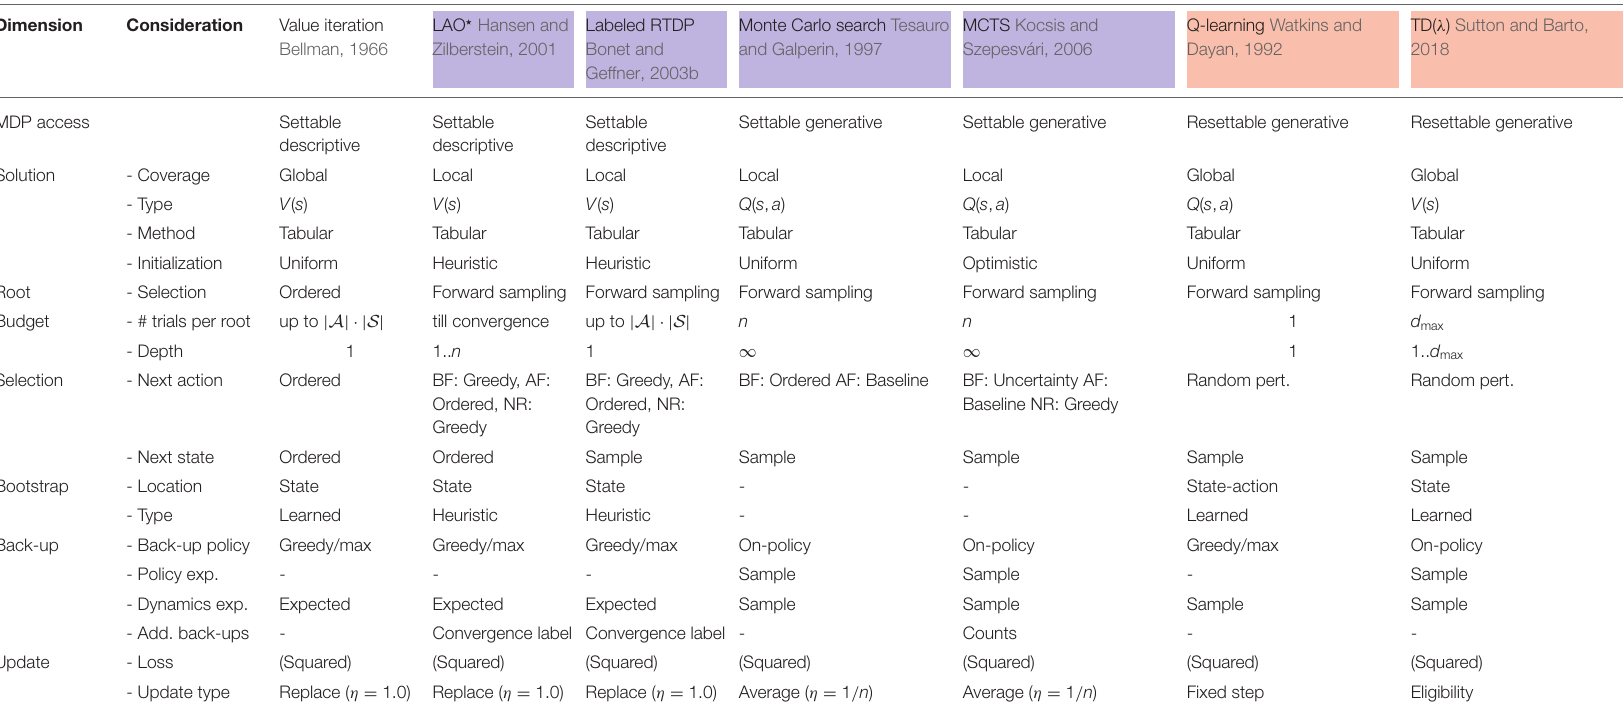
TABLE 7 | Comparison of algorithms (columns) along the framework dimensions (rows).